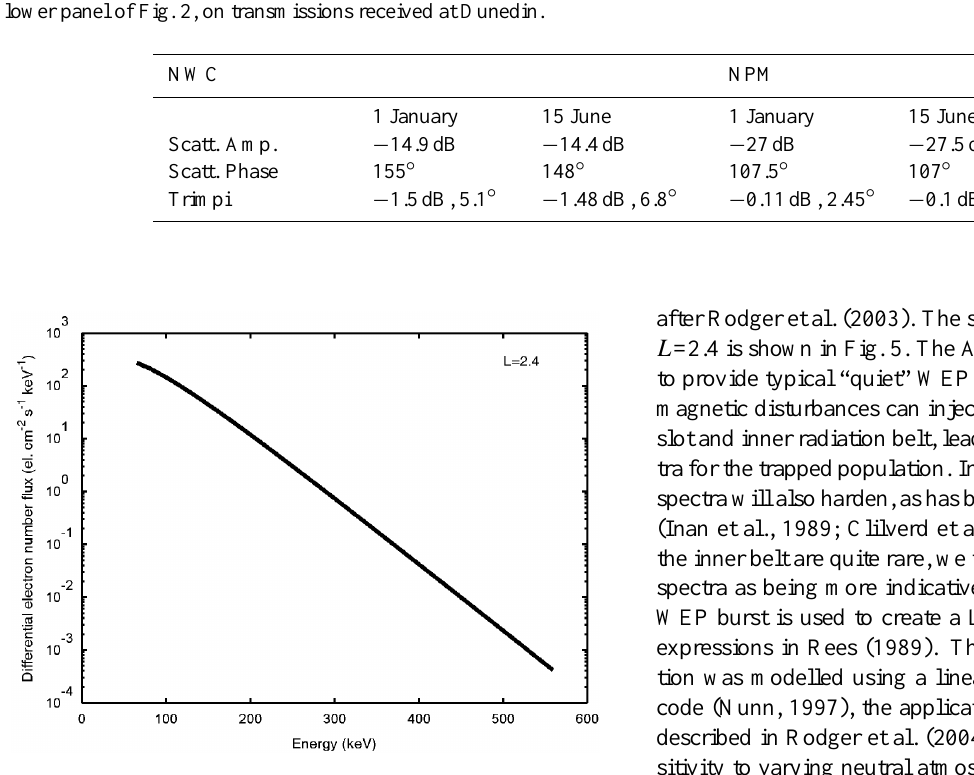
Fig. 5. Differential electron number flux of precipitated electrons in the WEP events used to model Trimpi observations undertaken from